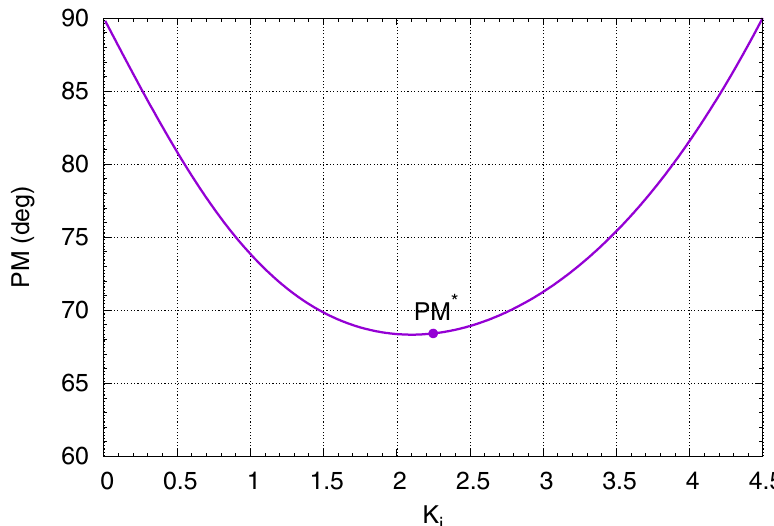
Figure 3. Plot of the phase margin, PM, versus the internal separation factor, K i , for a three-pole system designed with the constraint in (16). The point PM (cid:63) = 68.4deg identifies the phase margin ) = ( 8/3,9/4 ) . observed at the optimum bias point set by ( K (cid:63) e , K (cid:63) i